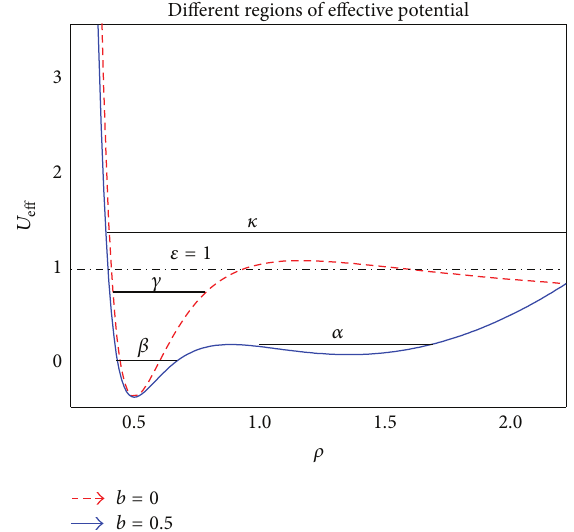
Figure 5: 𝛼 and 𝛽 are the regions which correspond to stable orbits for 𝑏 = 0.5 . For 𝑏 = 0 , the region 𝛾 corresponds to stable orbits.